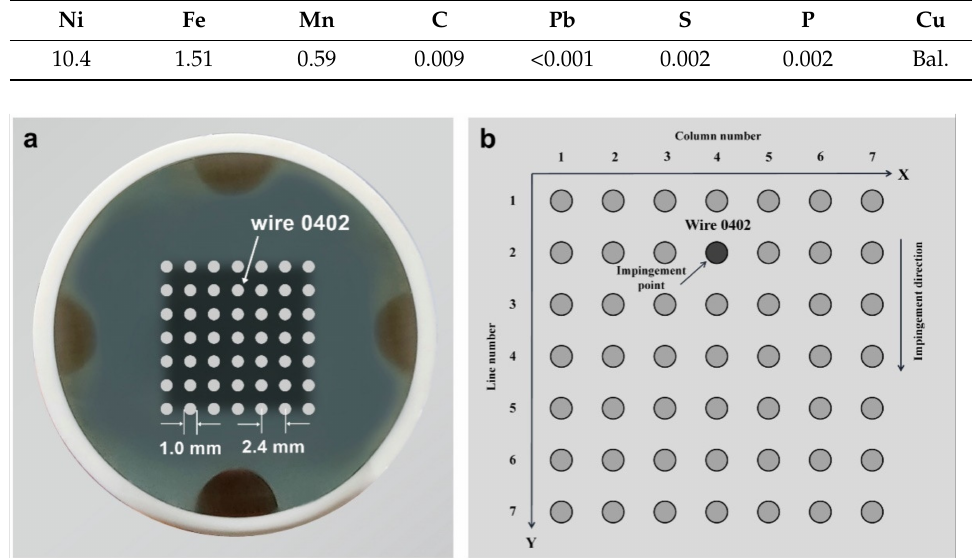
Table 1. The chemical compositions (wt.%) of the 90/10 copper–nickel alloy.